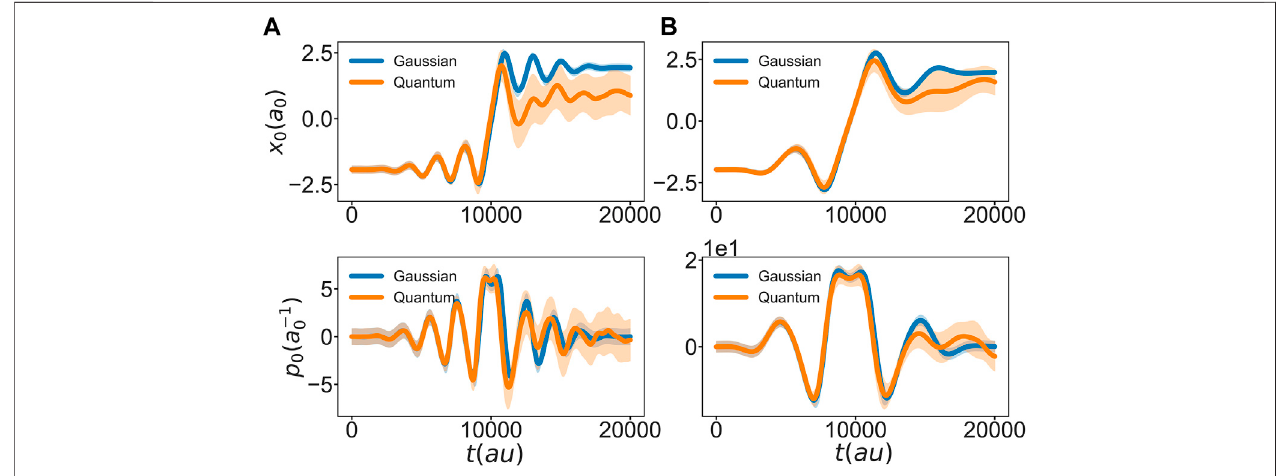
FIGURE 4 | Comparison of the coordinate (top row) and momentum (bottom row) expectation values and their respective standard deviation (shaded area), using the Gaussian approximation (blue) and the full quantum propagation (orange). Both trajectories are propagated under the in fl uence of the optimal control fi eld as obtained for the Gaussian (A) 1 m H (B) 5 m H ).